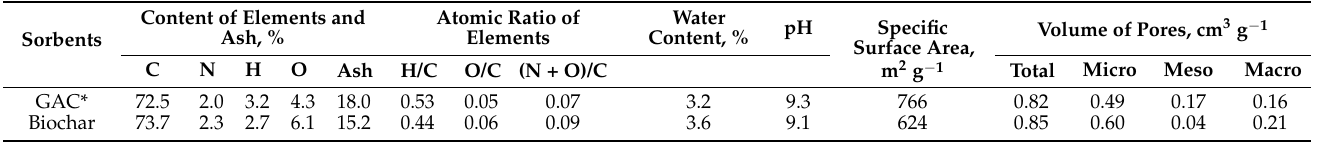
Table 2. Elemental composition, specific surface area, and porosity of the used carbonaceous sorbents. Content of Elements and Ash, Sorbents